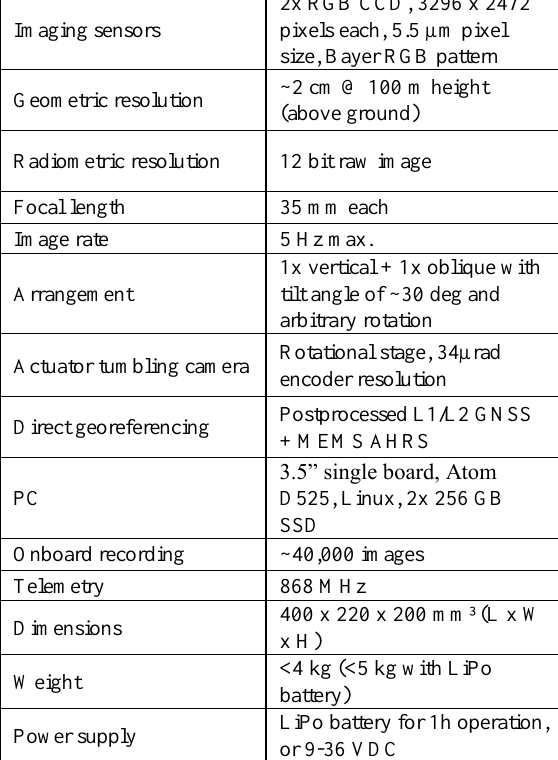
Table 1. Specifications MACS-TumbleCam